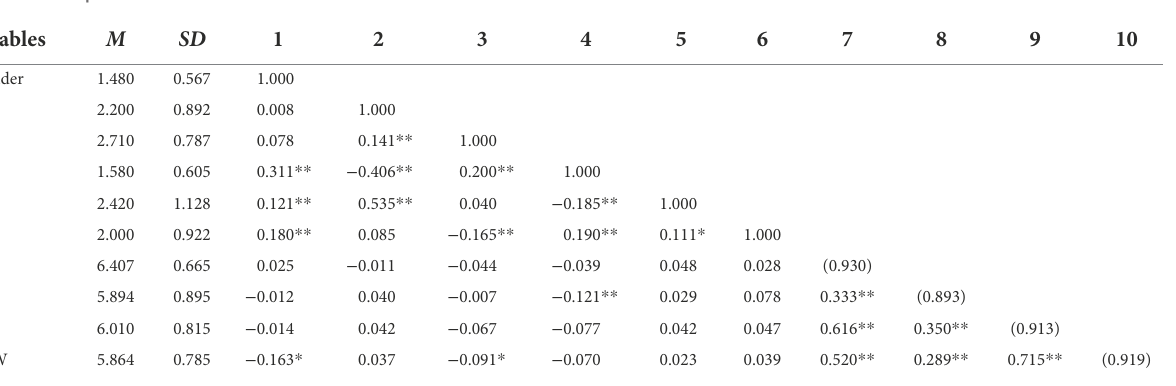
Innovative Behavior; SL, Spiritual Leadership; and TW, Thriving at Work.